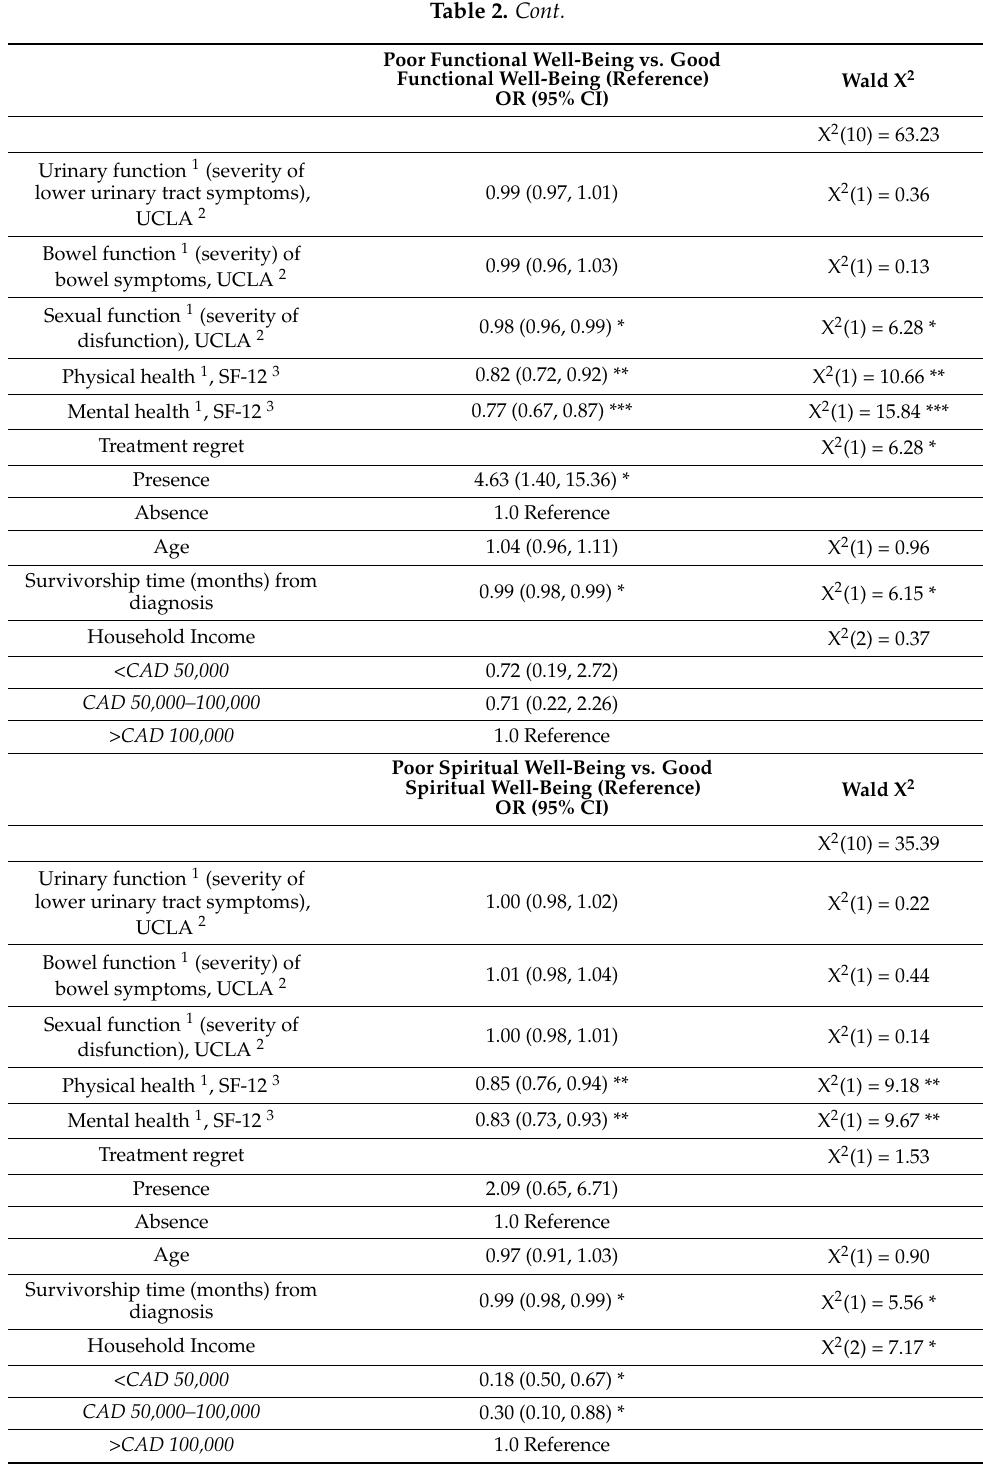
Poor Functional Well-Being vs. Good Functional Well-Being